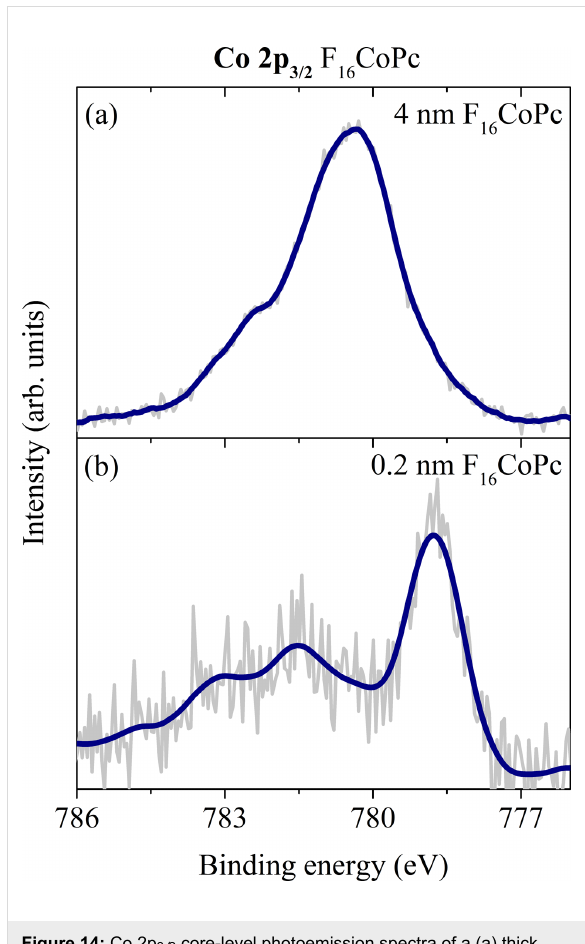
Figure 14: Co 2p 3 / 2 core-level photoemission spectra of a (a) thick and (b) thin F 16 CoPc layer on top of MnPc. The appearance of a struc- ture of low binding energy for the thin F 16 CoPc layer clearly indicates a reduction of the Co center in this molecule (adapted from